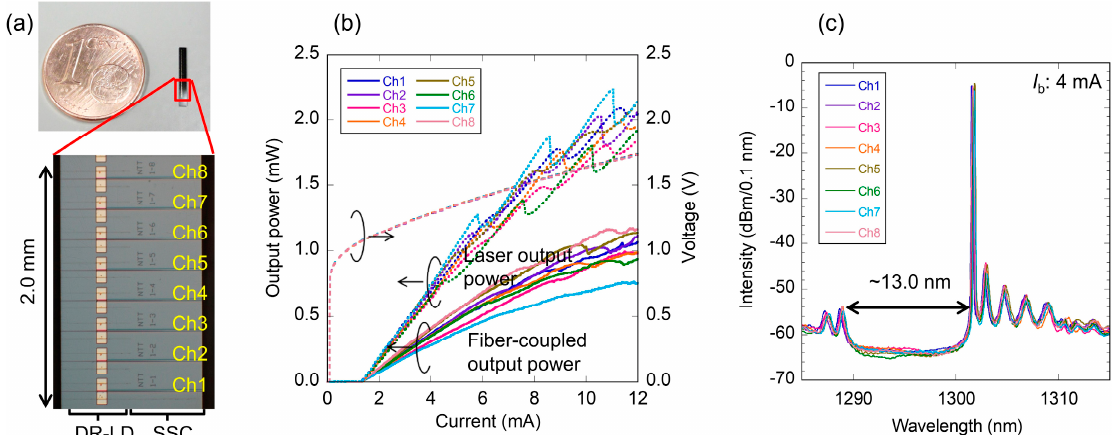
Figure 10. ( a ) Photograph of diced wafer that includes 4 8 ‐ channel laser arrays, together with top ‐ view photograph of one 8 ‐ channel laser array; ( b ) bias ‐ current dependence of optical output power and bias voltages at 25 °C; ( c ) lasing spectra with bias current of 4 mA at 25 °C.